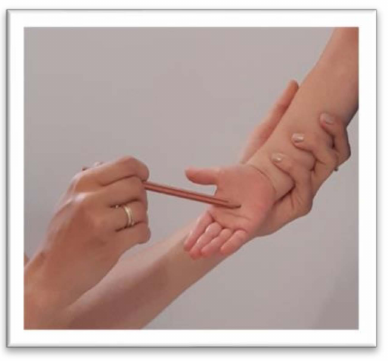
Figure 8. Position for the examination of Galant reflex for the right side.